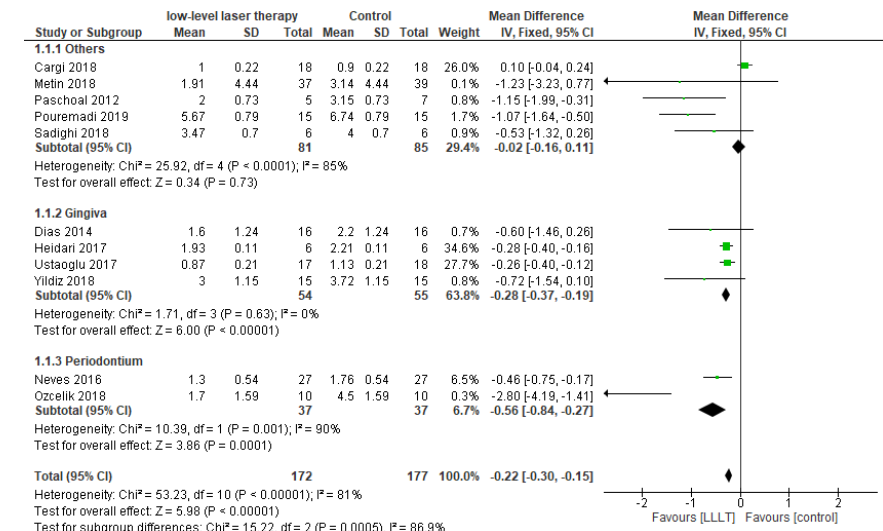
Figure 2. Post-operative analysis of wound tissue re-epithelization 1 day postoperative